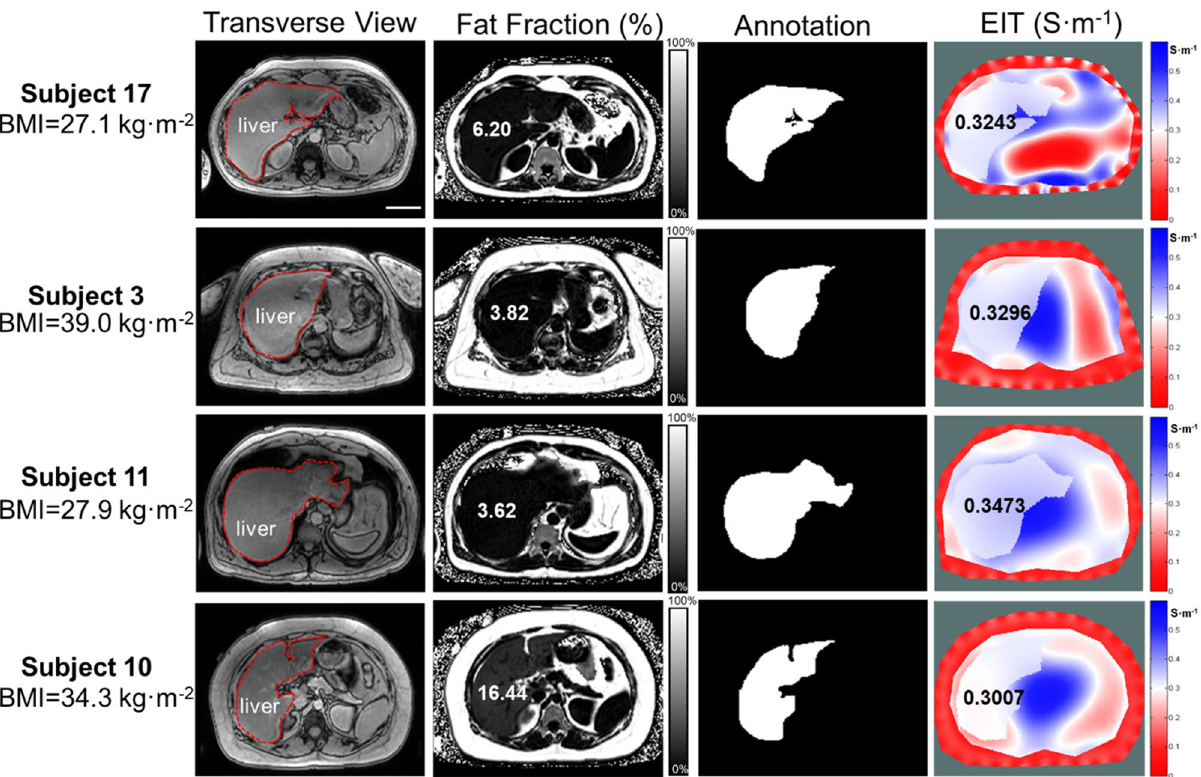
Figure 2. Representative MRI multi-echo and EIT images. Four representative subjects with different BMI values (Kg· m −2 ) were compared with MRI PDFF (%) and EIT conductivity (S·m −1 ), respectively. The transverse MRI views demarcate the liver anatomy, the fat fractions provide the corresponding MRI PDFF, annotation reveals the liver boundary condition following image segmentation, and 2-D EIT images unveil the abdomen conductivity distribution and average liver conductivity. The subject 17 with a BMI of 27.1 kg·m −2 developed a relatively high MRI PDFF (6.2%) and a low EIT liver conductivity (0.3243 S·m −1 ); whereas the subject 3 with BMI of 39 kg·m −2 developed a relatively low MRI PDFF (3.82%) and high EIT liver conductivity (0.3296 S·m −1 ).